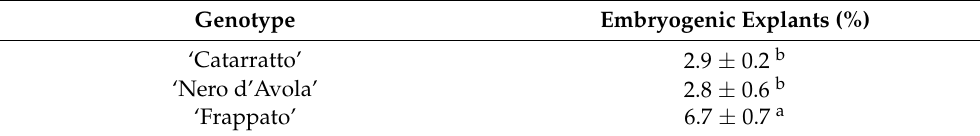
Table 3. Genotype specificity of somatic embryogenesis.